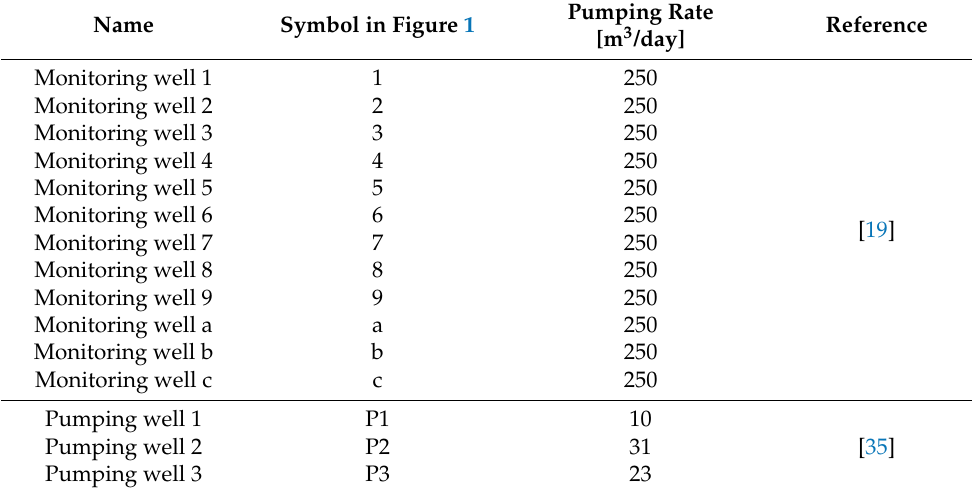
Table 4. Pump specifications by active